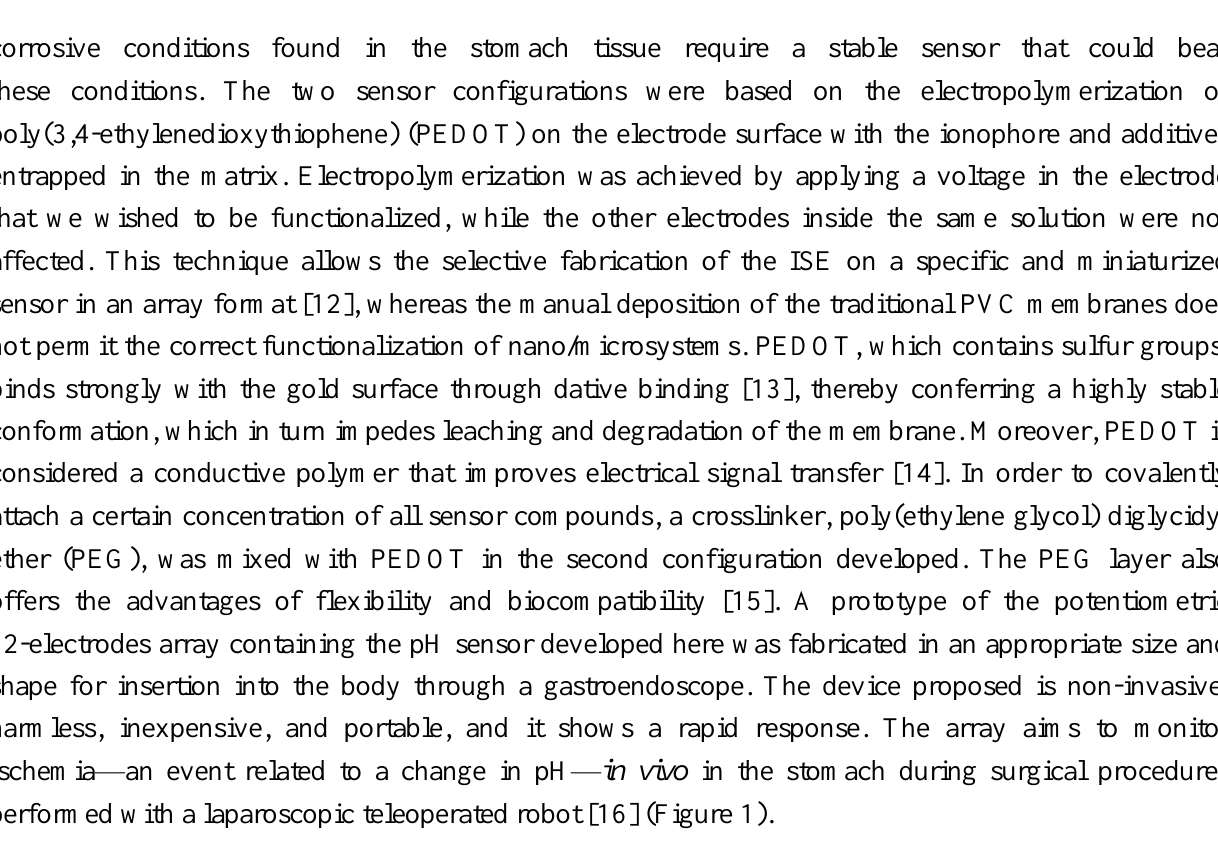
Figure 1. Picture of the developed sensor array inserted in a gastroendoscope. The inlet picture shows the size of the